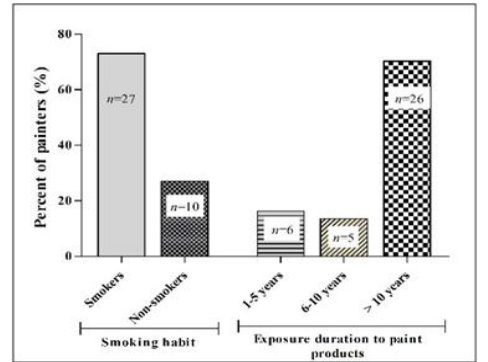
Figure (1): Distribution of painters (%) according to smoking habits and duration of exposure to painting products in the work